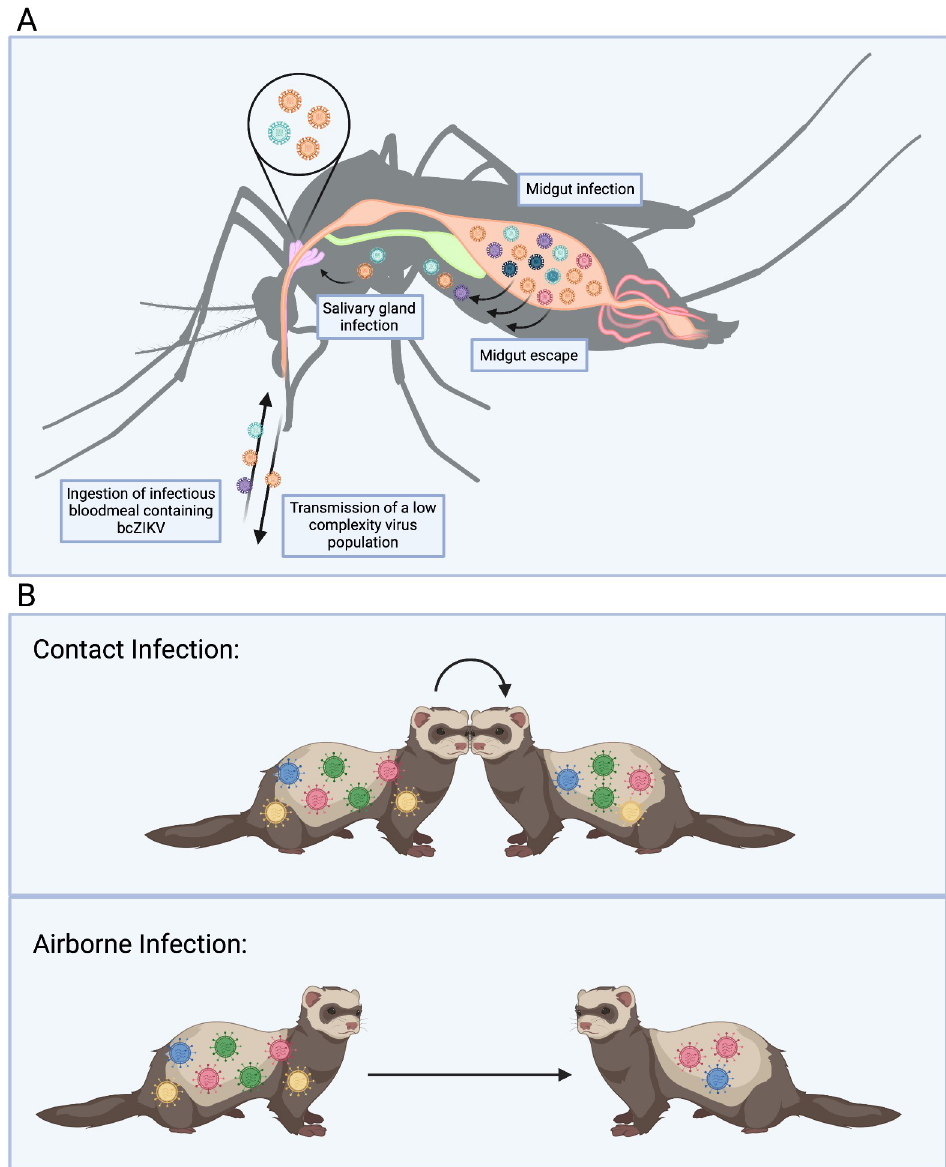
Fig 2. Barcoded viruses mimic virus population dynamics during transmission and infection events. (A) Intrahost bottlenecks in Ae . aegypti rapidly reduce the complexity of a bcZIKV population during mosquito infection. ( B) A more complex bcIAV population is transmitted between ferrets via contact infection than airborne infection. (Created with